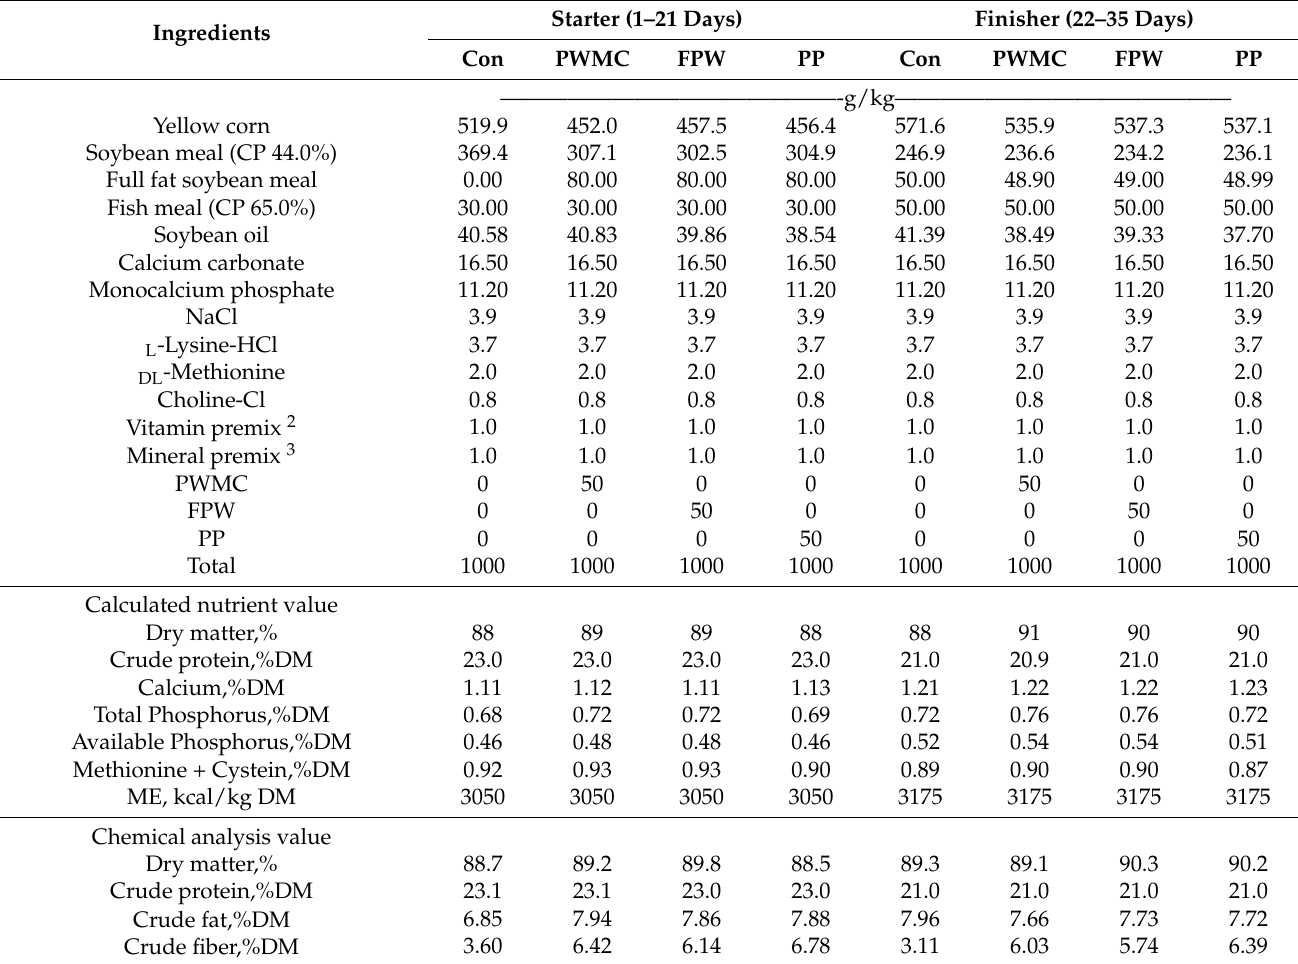
Table 1. Composition and calculated analysis (g/kg, as fed) of the basal and experimental diets for broilers, for both the starter diet (1–21 days) and the finisher diet (22–35 days) 1